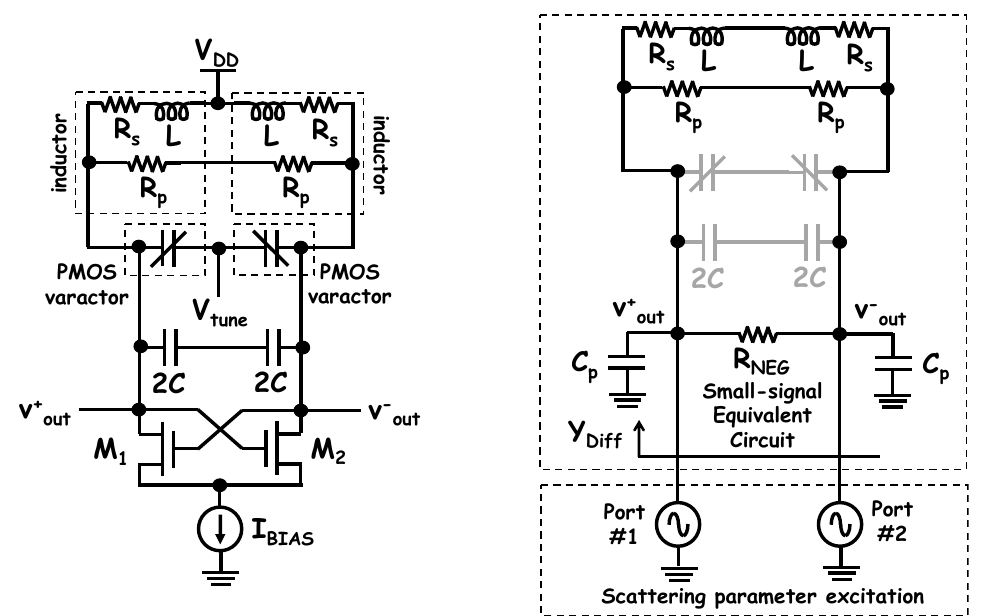
Figure 3. N-type cross-coupled oscillator: schematic ( left ) and small-signal model of the differential admittance Y Diff ( right ).